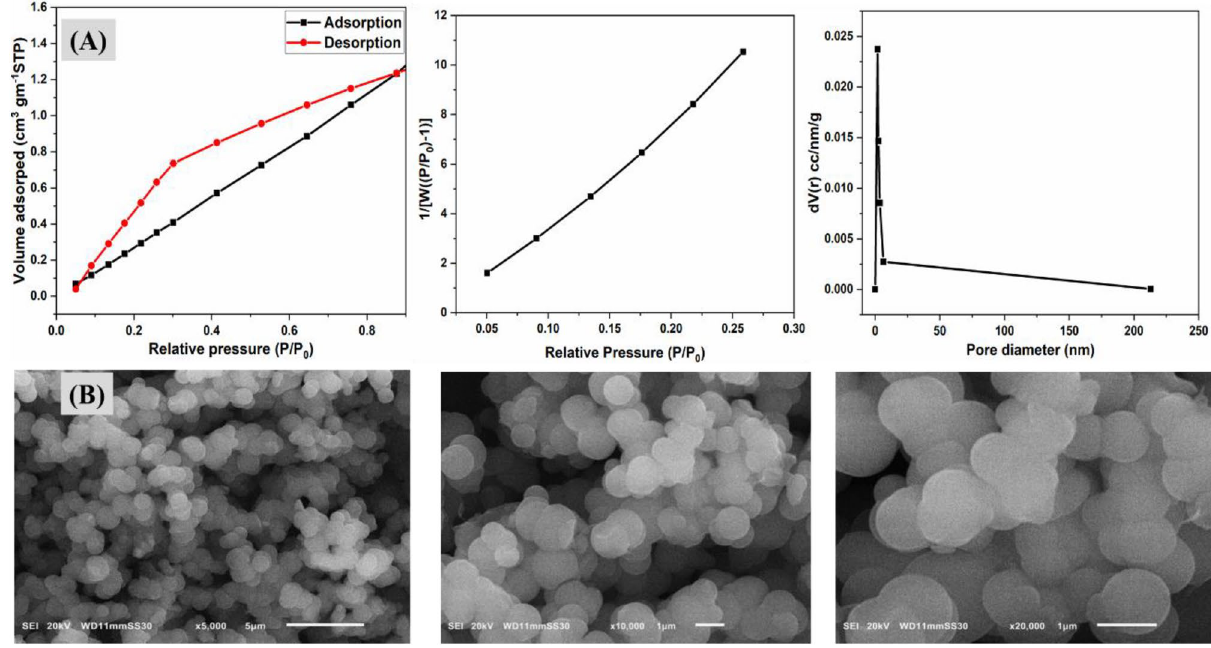
Figure 4. ( A ) BET nitrogen adsorption isotherm plot BET surface area and pore size distribution, ( B ) SEM- EDX images at different magnifications of